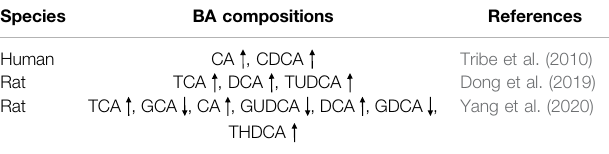
TABLE 2 | The change of BA compositions in patients and rats with